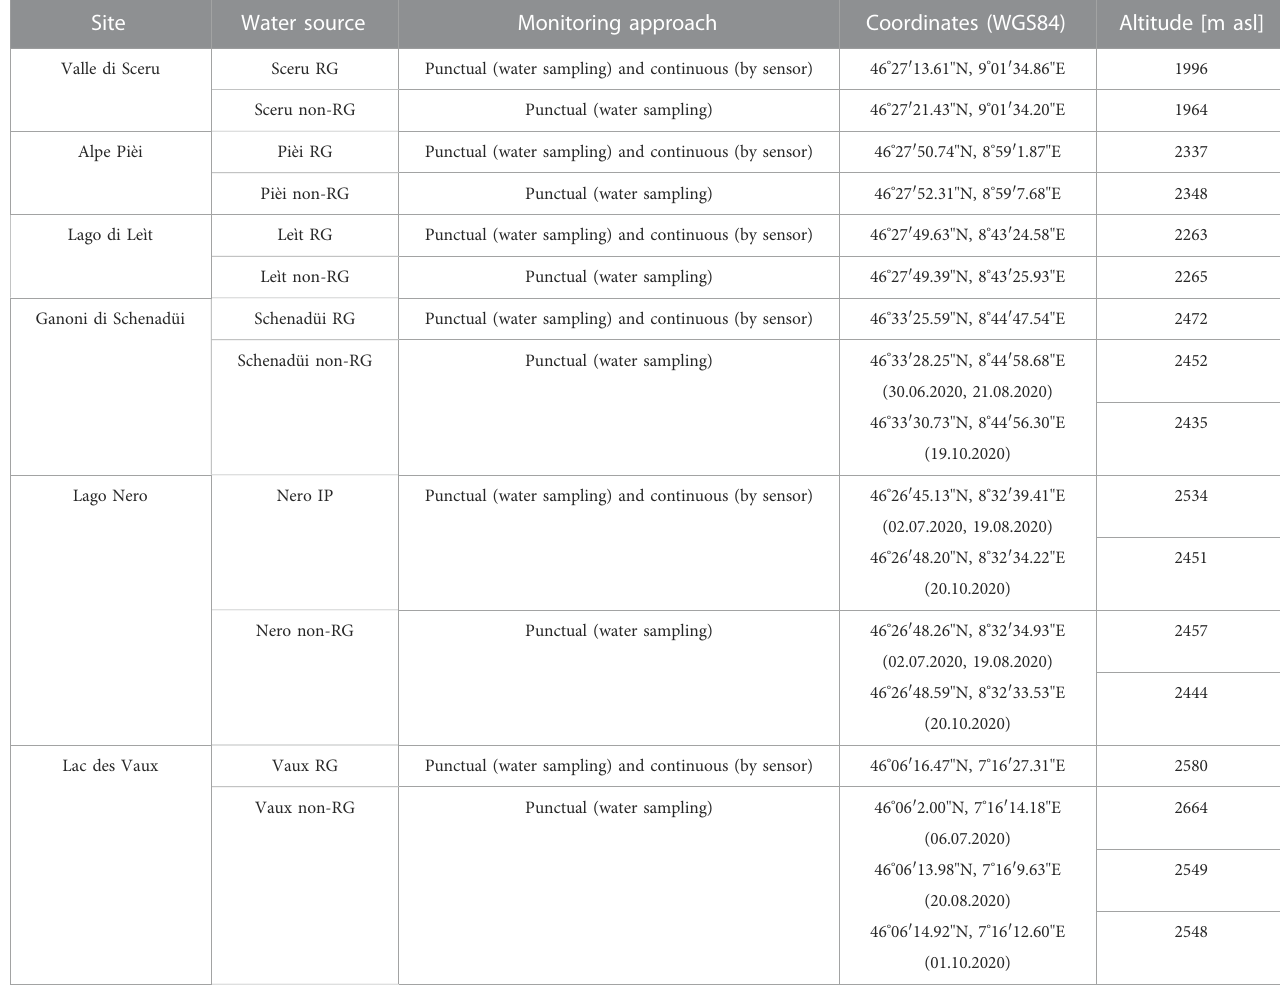
TABLE 3 Description and location of the analyzed water